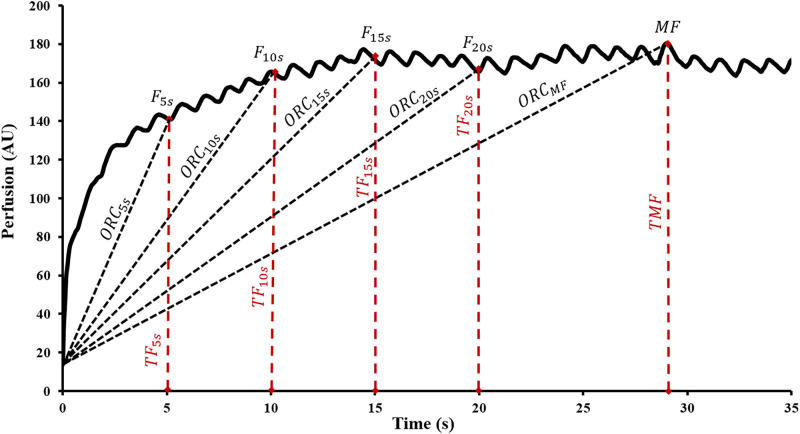
Piecewise overshoot rate of change.5s intervals from 5-20s (ORC5s,10s,15s,20s) hyperemic response illustrated in this tracing obtained from experimental data. Time = 0 corresponds to cuff deflation.